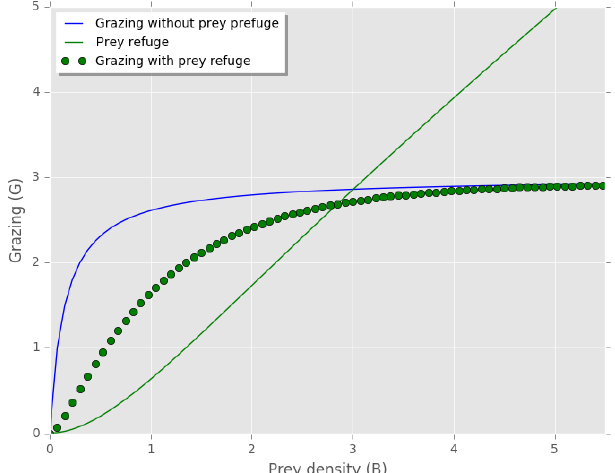
(cid:16) (cid:17) 1 − e − (cid:51)F (Mayzaud